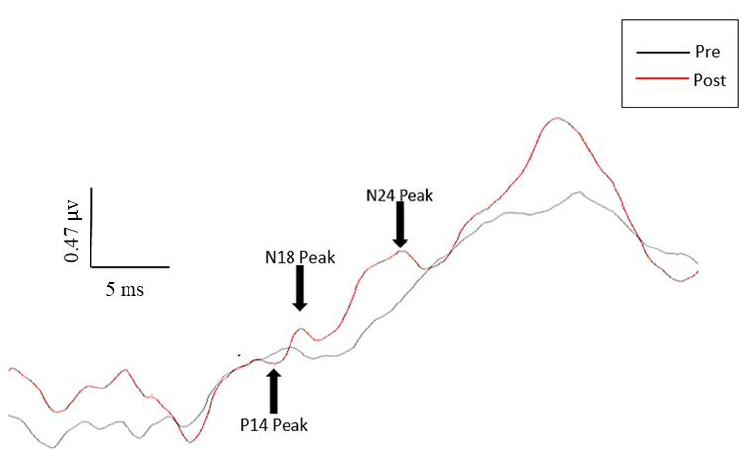
Figure 6. Pre- and post-tracing intervention SEP peaks for one representative participant. Black trace is the pre-intervention trace; red trace is the post-intervention trace. Note the large increases in amplitude for the P14, N18, and N24 peaks.